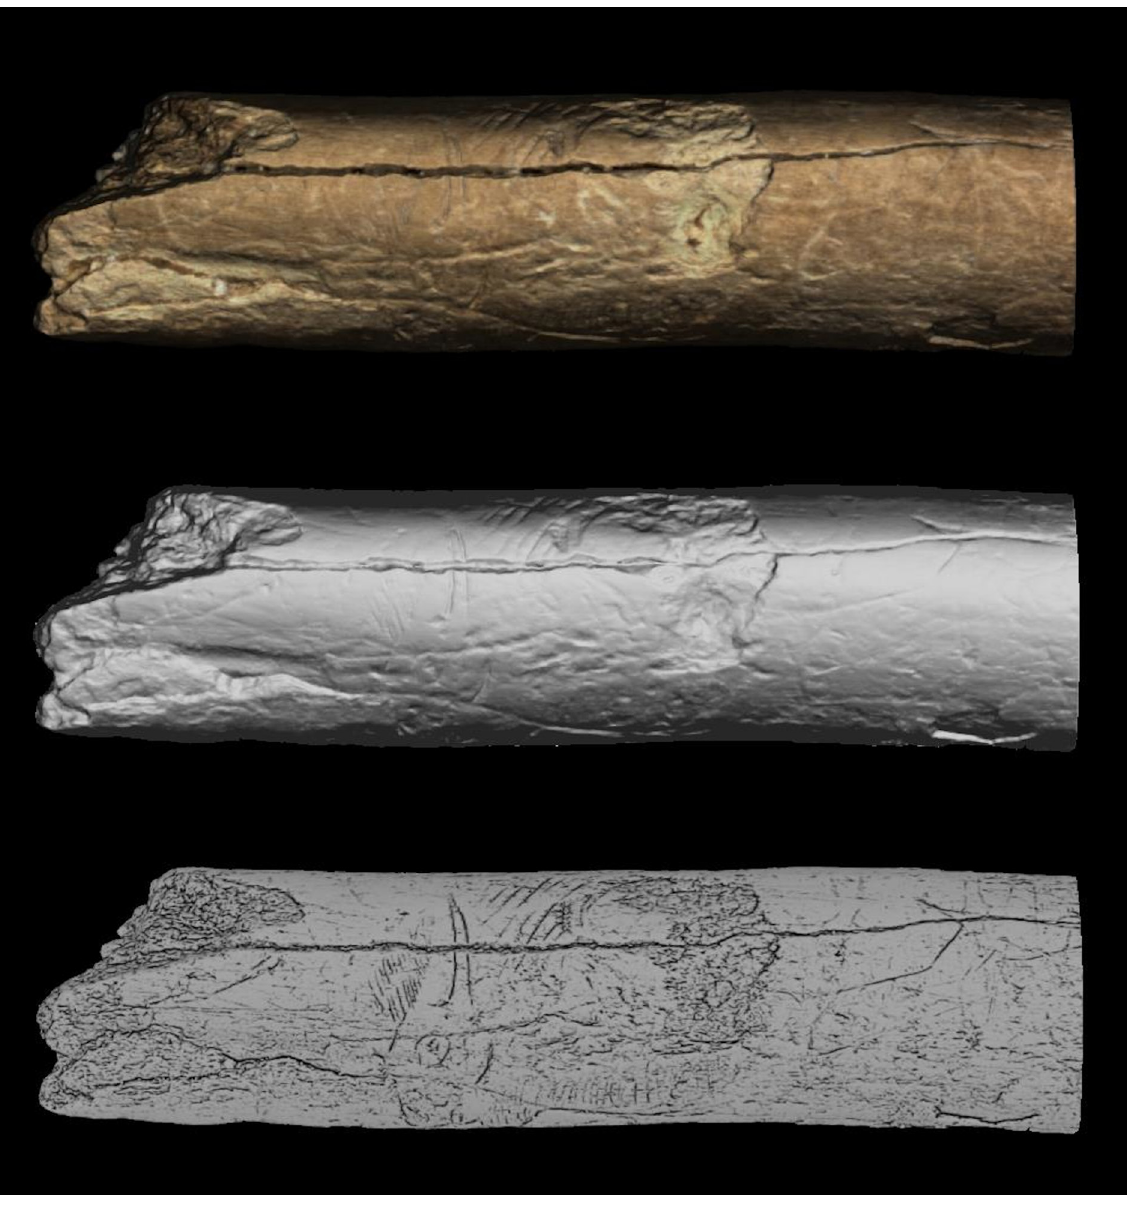
Fig. 2.30. 3D model of a mobile Palaeolithic art from “le Trou des Nutons”. Above: coloured surface model; middle: Surface without texture; below: image processed with automatic filtering method to highlight surface features of bison bone. The acquisition was made with a 5 Mpx RGB machine vision